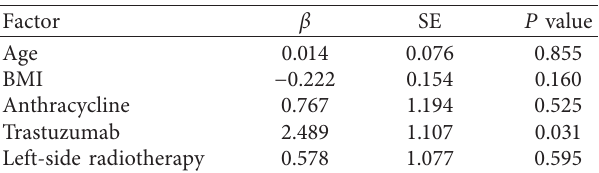
Table 3: Multivariate analysis for GLS in breast cancer patients with metabolic syndrome after